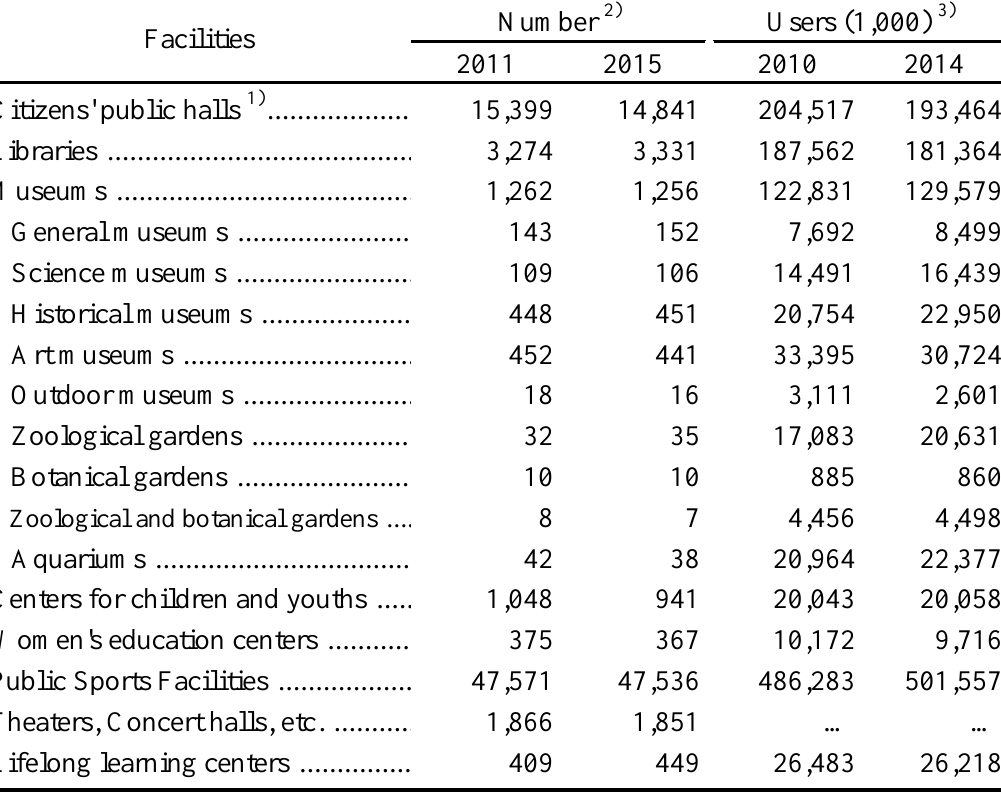
Social Education Facilities and